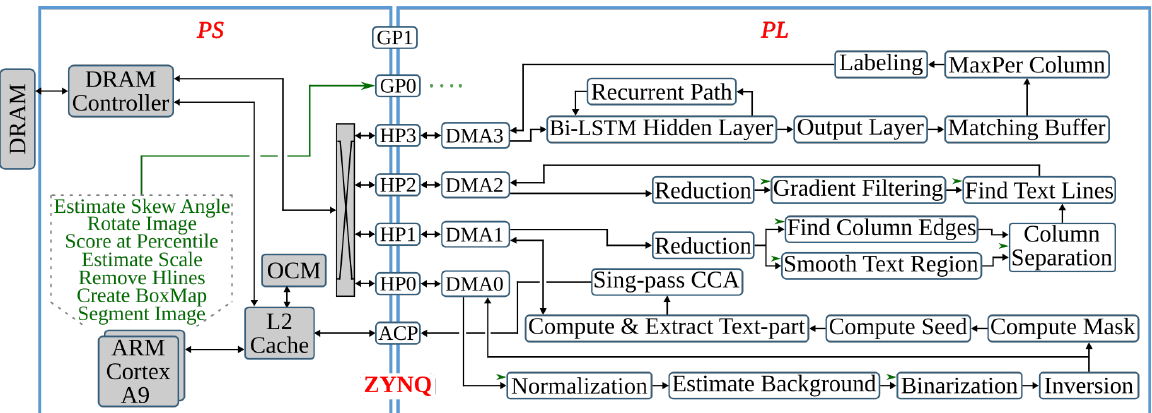
Figure 26. Zynq implementation of Text and Image Segmentation hardware